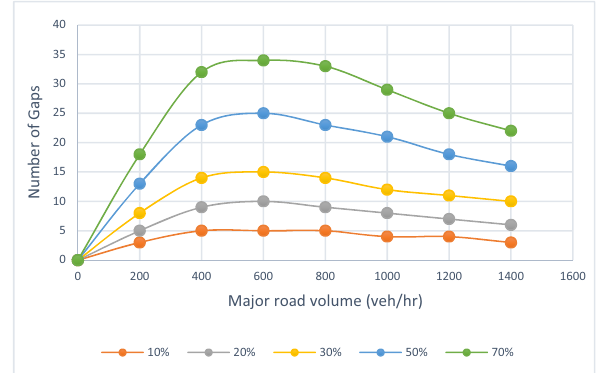
Figure 2: Number of gaps CAVs can possibly help create for left